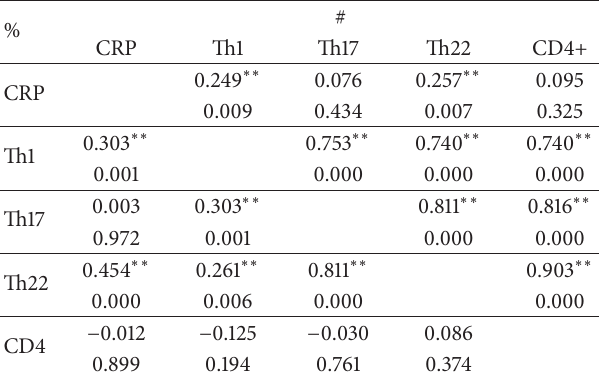
Table 2: Correlation coefficients between each proinflammatory Th subset and